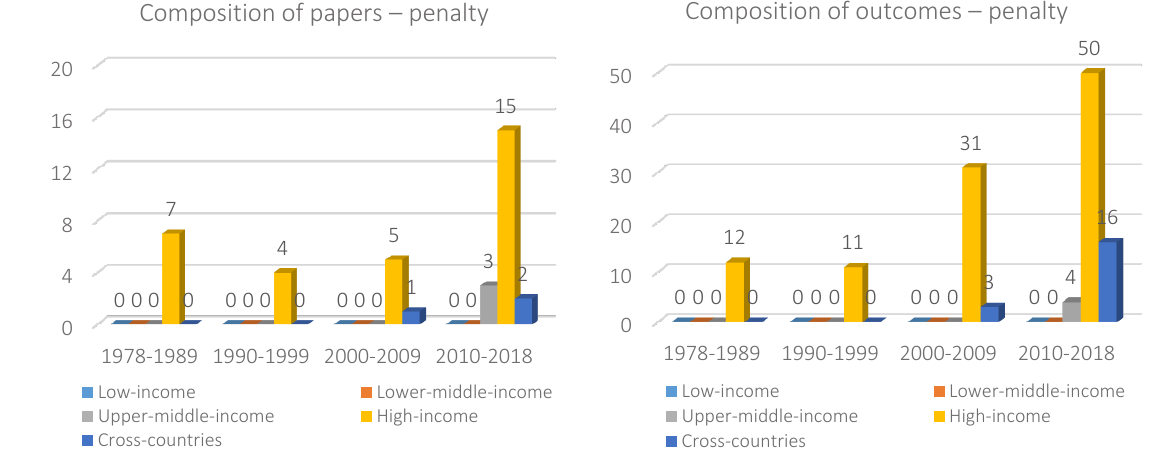
Figure 2. Composition of papers and outcomes – penalty